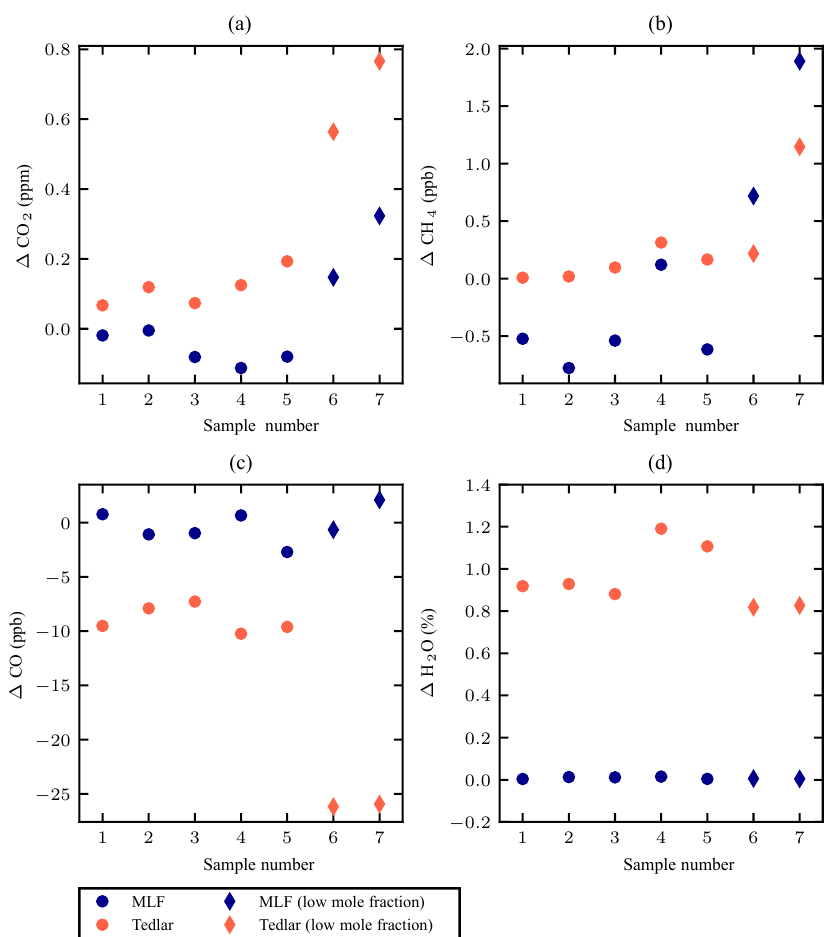
Figure 2. The observed drift of the mole fractions of CO 2 (a) , CH 4 (b) , CO (c) , and H 2 O (d) in each of seven samples in both Tedlar and MLF bags. The drift is defined as the difference between the measured mole fractions after 4h and those measured immediately after filling. For CO 2 , the mole fractions of samples nos. 1–5 are representative for stratospheric mole fractions. Samples nos. 6 and 7 contain low mole fractions and represent a typical mole fraction of stratospheric CH 4